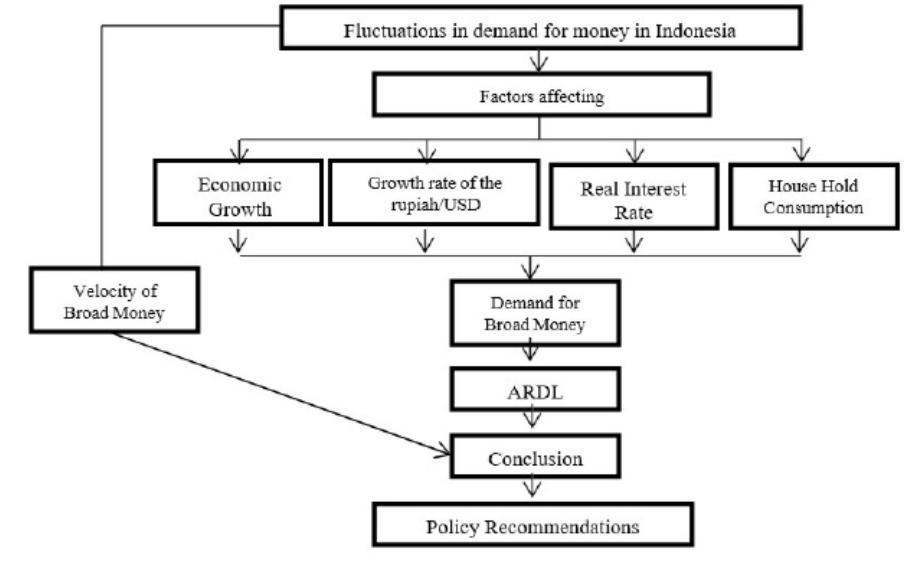
Figure 2: Conceptual